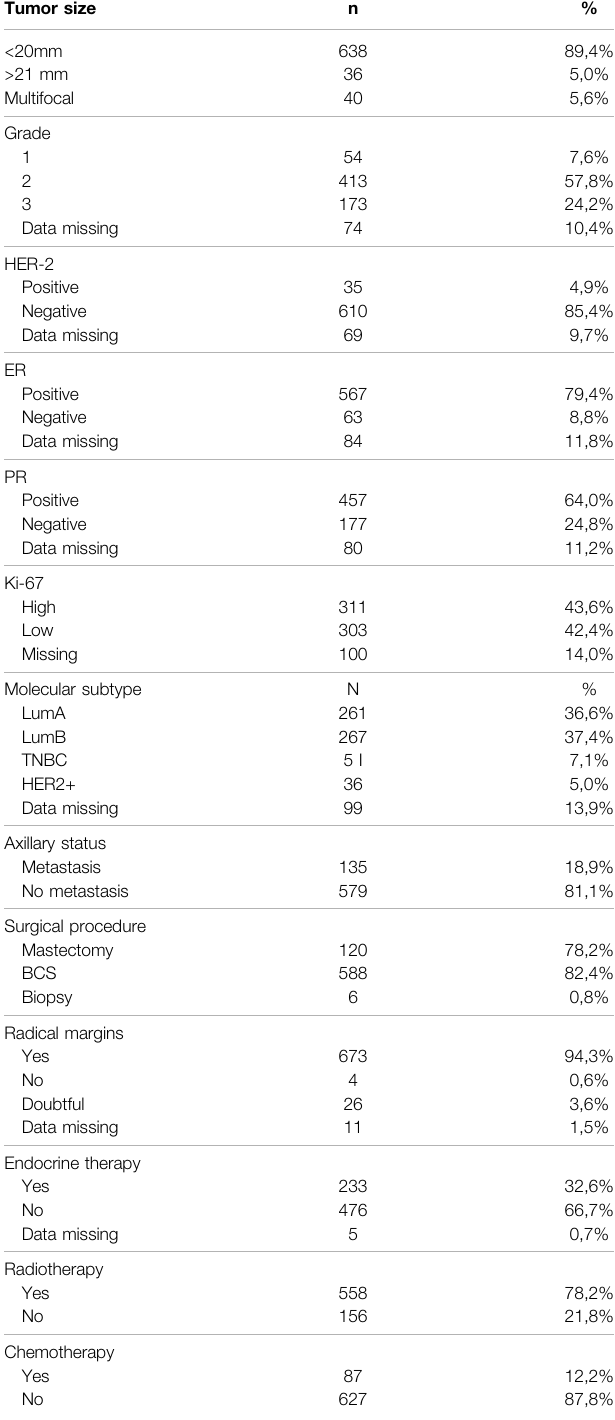
TABLE 1 | Patient characteristics of the